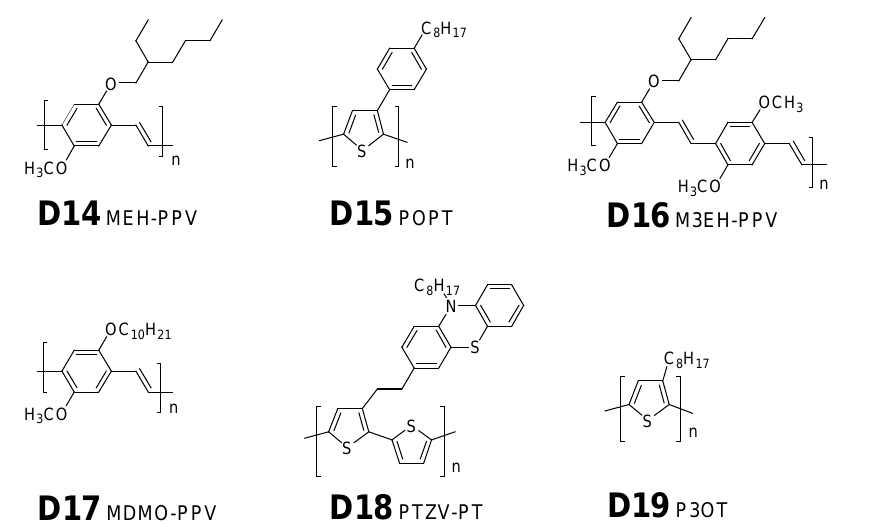
Figure 8. Molecular structures of polymer donors ( D14 – D19